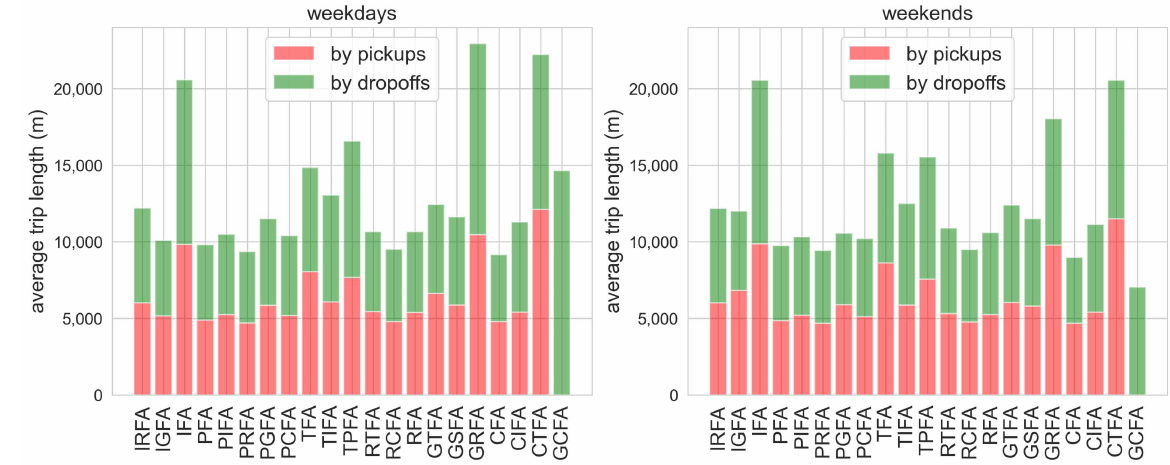
Figure 5. Daily average travel distance of each UFA type on weekdays and